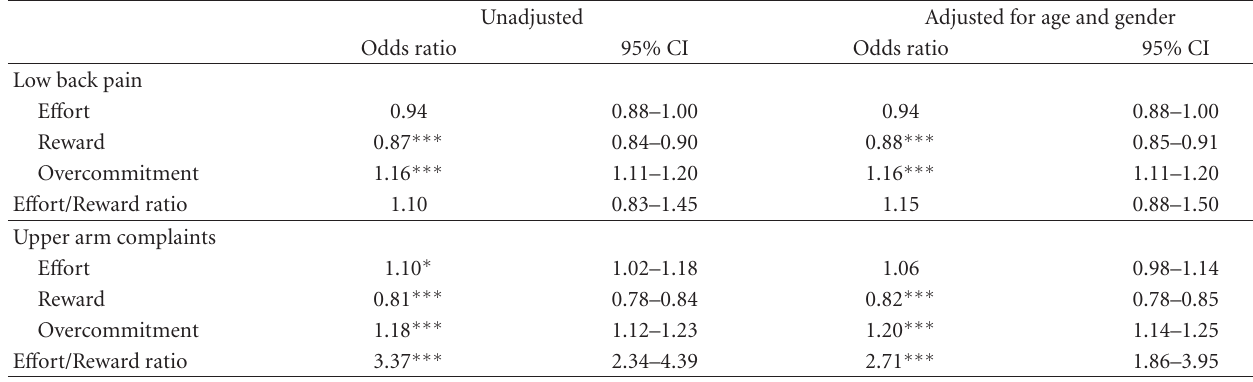
Table 4: Associations of the scales of the short e ff ort-reward imbalance questionnaire with acute low back pain and musculoskeletal problems at the upper arm (logistic regression analyses) (Odds ratios and 95% confidence intervals (CI)).